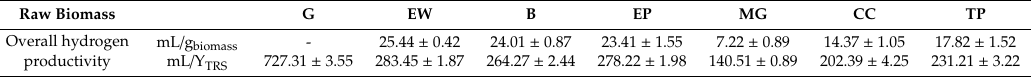
Table 6. Hydrogen productivity for di ff erent raw materials after 48